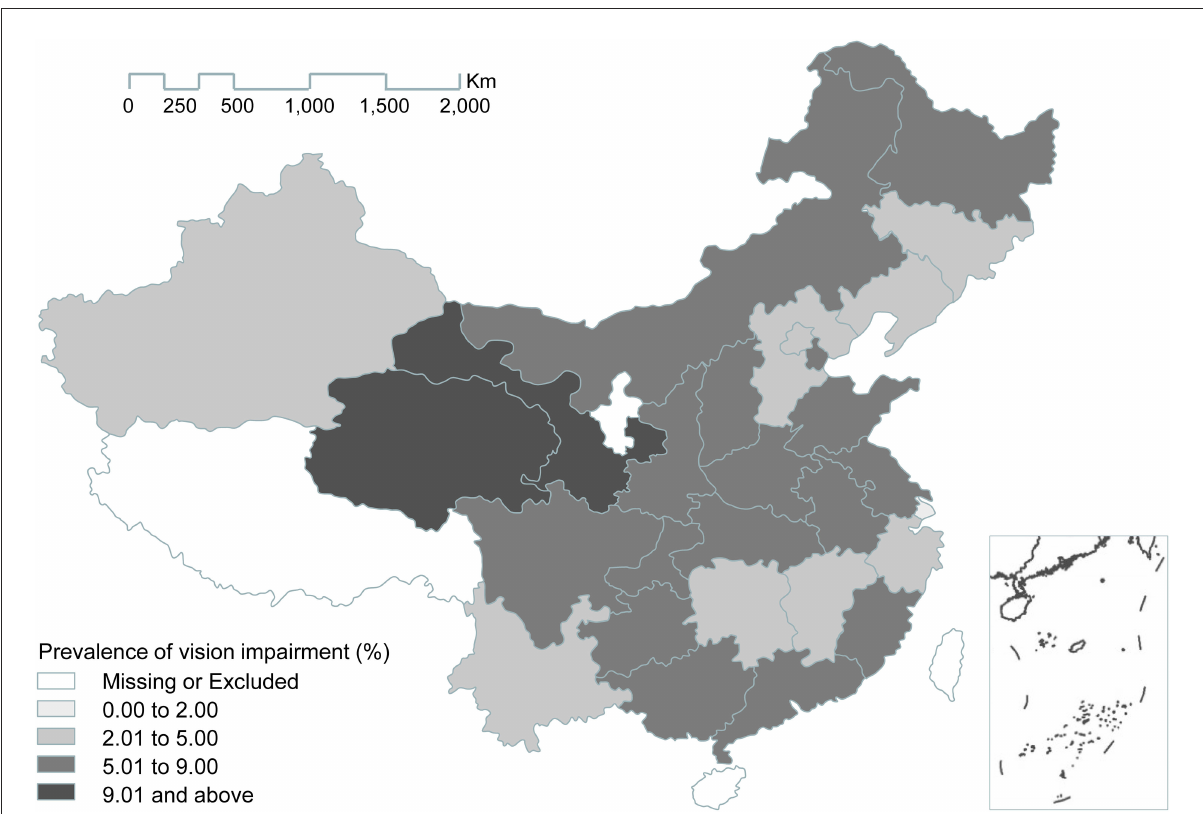
FIGURE1 Prevalence of visual impairment in different provinces of